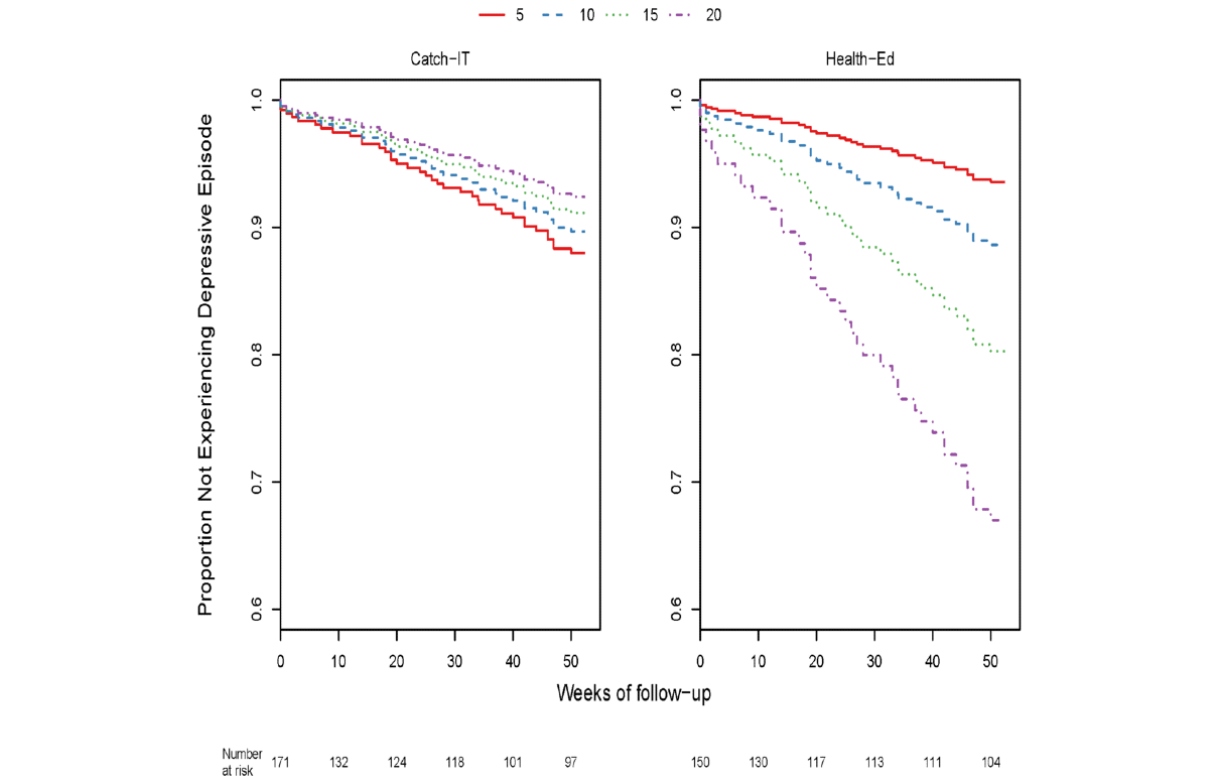
Figure 2. Adolescent CES-D Scale score at baseline and time to Depression Symptom Rating>3–event at 12 months, excluding those who enrolled with no depressed mood.